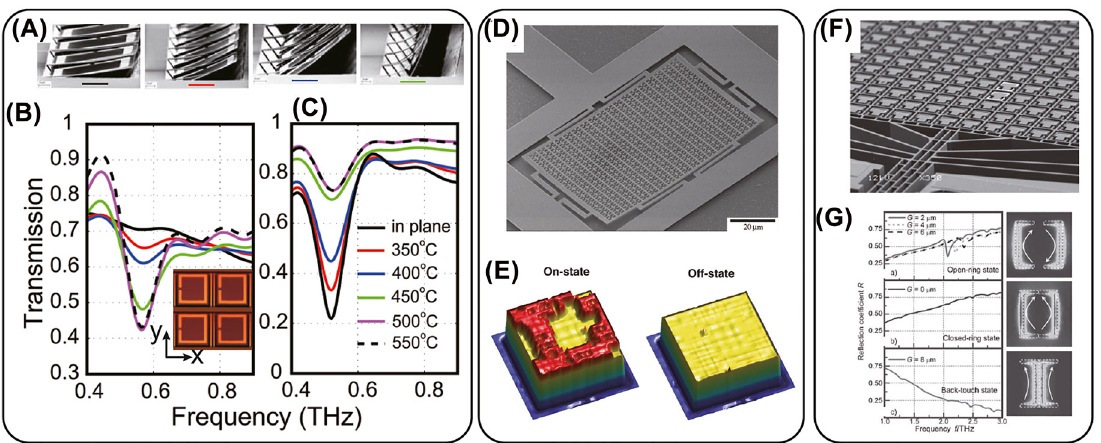
Figure 9: MEMS based tunable metasurfaces. (A)–(C) Reconfigurable terahertz metamaterials. (A) SEM images of metamaterial array rotated with the bimaterial beams annealed at various temperatures. THz transmission response of the SRR changing with the rotation angle for magnetic field along the y -direction (B) and electric field polarized along the y -direction (C). The inset in (B) is the microscope image of the as-fabricated SRRs before annealing process. (A)–(C) Reprinted from [93]. Copyright 2009, American Physical Society. (D) SEM image of an MEMS metasurface emitter. (E) Measured emitted power density of an 8 × 8 dynamic emitter array with an IR camera in on and off states. (D) and (E) reprinted from [232]. Copyright 2017 Optica. (F) SEM image of a fabricated comb-drive actuated magnetic metamaterial. (G) The measured reflection coefficient of the metamaterial with different open-ring states from gap size G = 0 μ m to G = 8 μ m. G = 0 μ m and G = 8 μ m are closed-ring state and back-touch state, respectively. (F) and (G) reprinted from [233]. Copyright 2011 John Wiley &